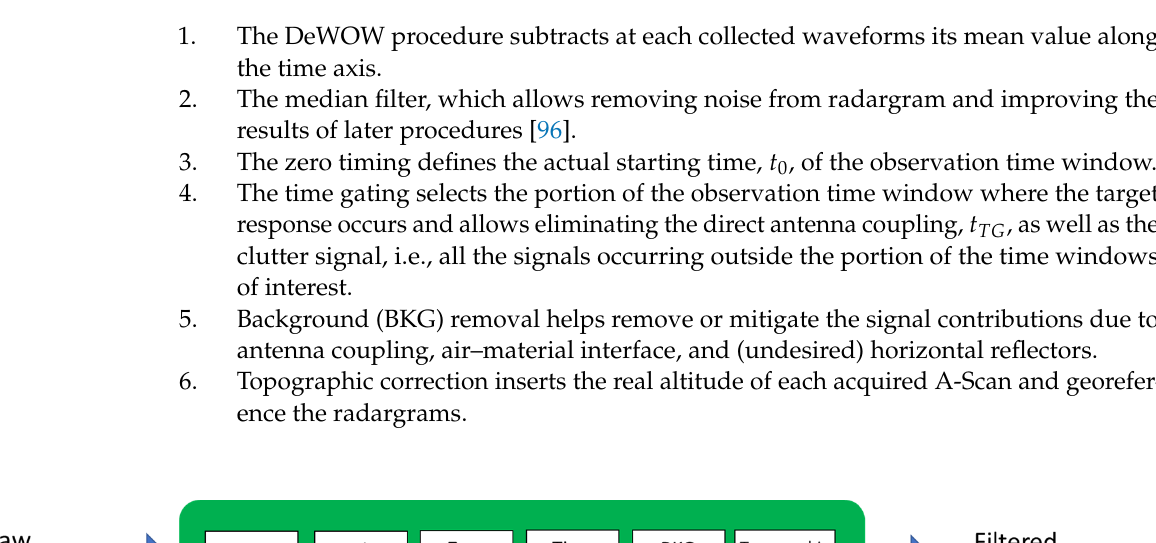
Figure 11. Results of profile Seis_1 (see Figure 3) with the detection of inferred position of faults (black dashed lines).